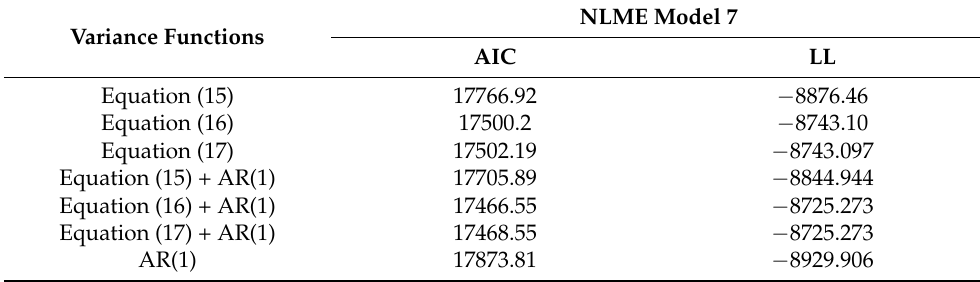
Table 7. Fit statistics of three variance functions (exponential function, power function, and constant plus power function) applied to the NLME DH model (LL,